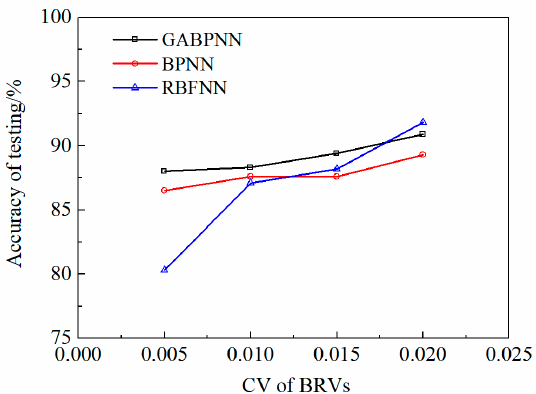
Figure 10. The comparison of the testing accuracy of the ANNs in the IP study under the shock load condition where v is 1000 m/s.